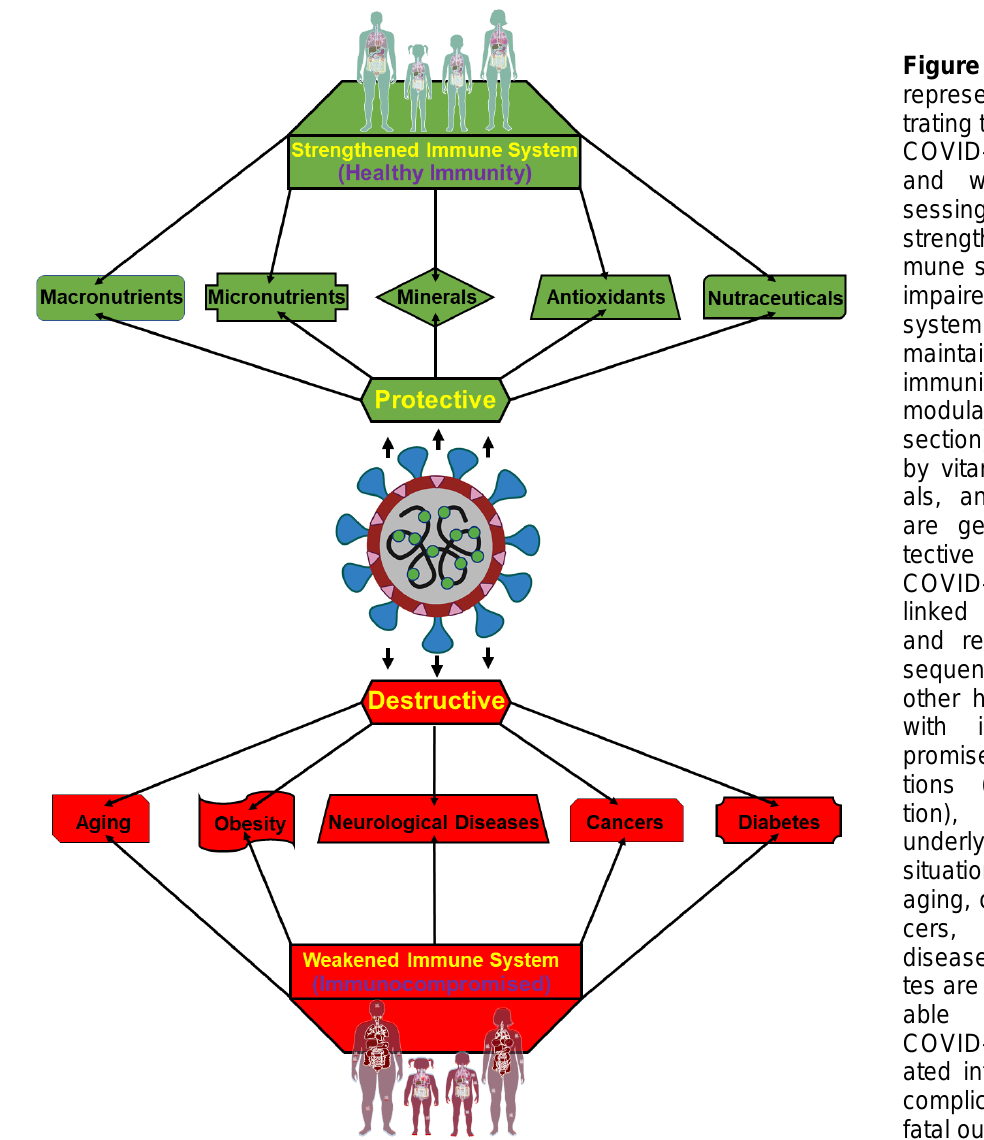
Figure 3: Graphical representation